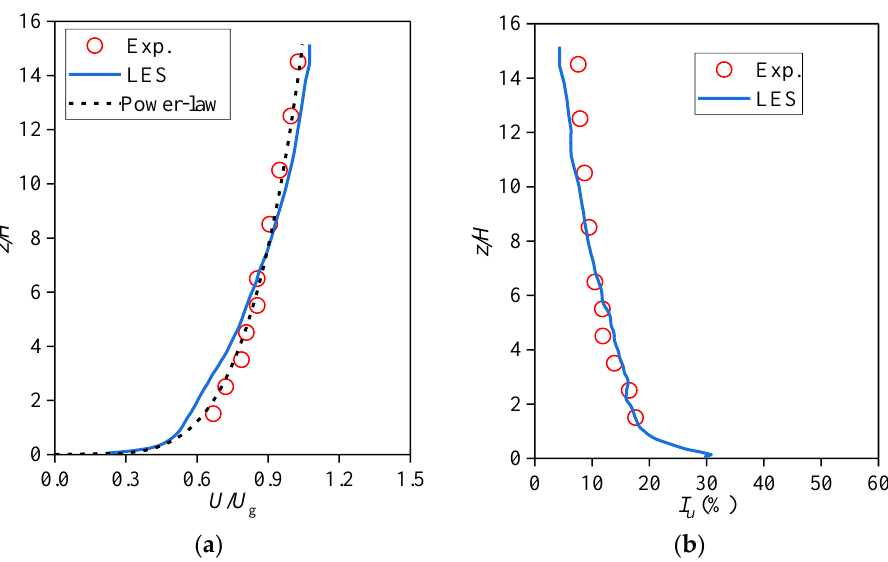
Figure 9. Approaching flow characteristics obtained from LES and experiment without immersing building models. ( a ) Normalized stream-wise mean velocity U / U g , where U g is mean wind velocity at boundary layer height δ for wind tunnel experiment. ( b ) Stream-wise turbulence intensity I u .